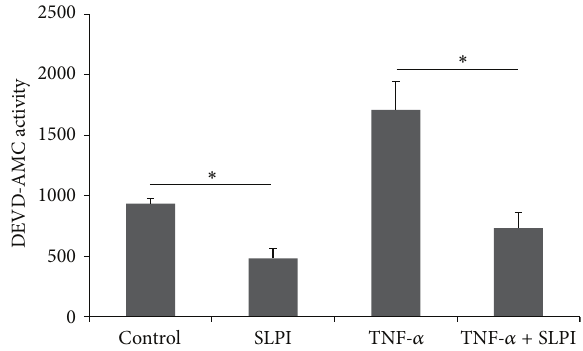
Figure 2: Effect of SLPI on TNF- 𝛼 -induced caspase-3 and caspase-7 activity in peripheral blood monocytes. Peripheral blood monocytes were isolated and pretreated for 1 hr with SLPI (10 𝜇 g/mL) and then incubated with TNF- 𝛼 (10ng/mL) for 4 hr. Activity of the effector caspases, caspase-3 and caspase-7, was measured using the fluorogenic substrate DEVD-AMC. Results are representative of 𝑛 = 6 . ∗ indicates 𝑝 < 0.05